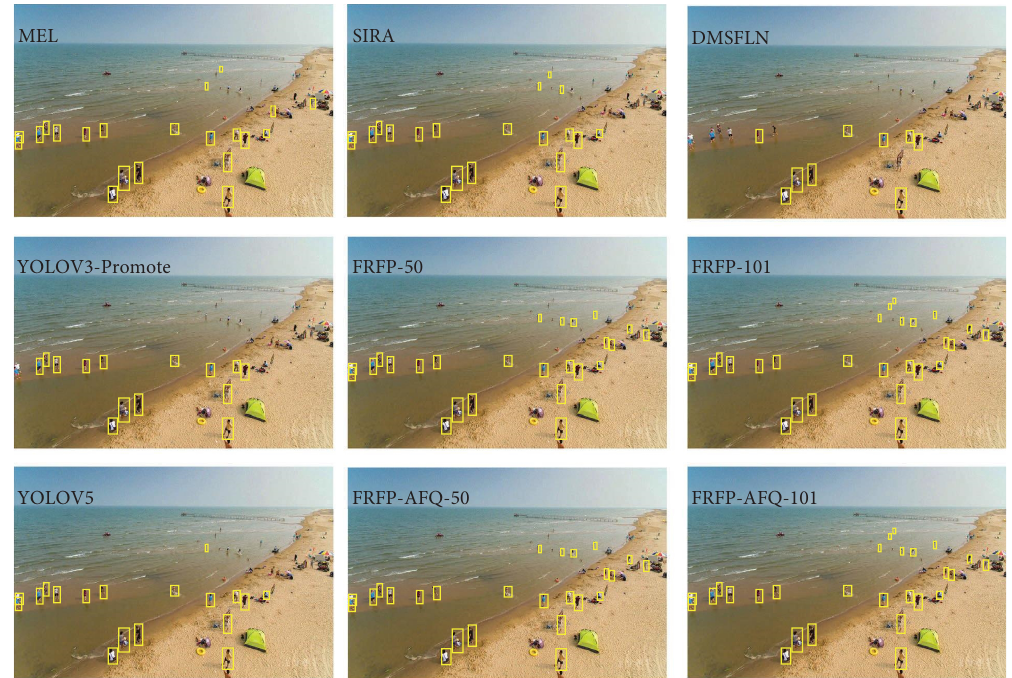
Figure 10: Comparison results with conventional pedestrian detection